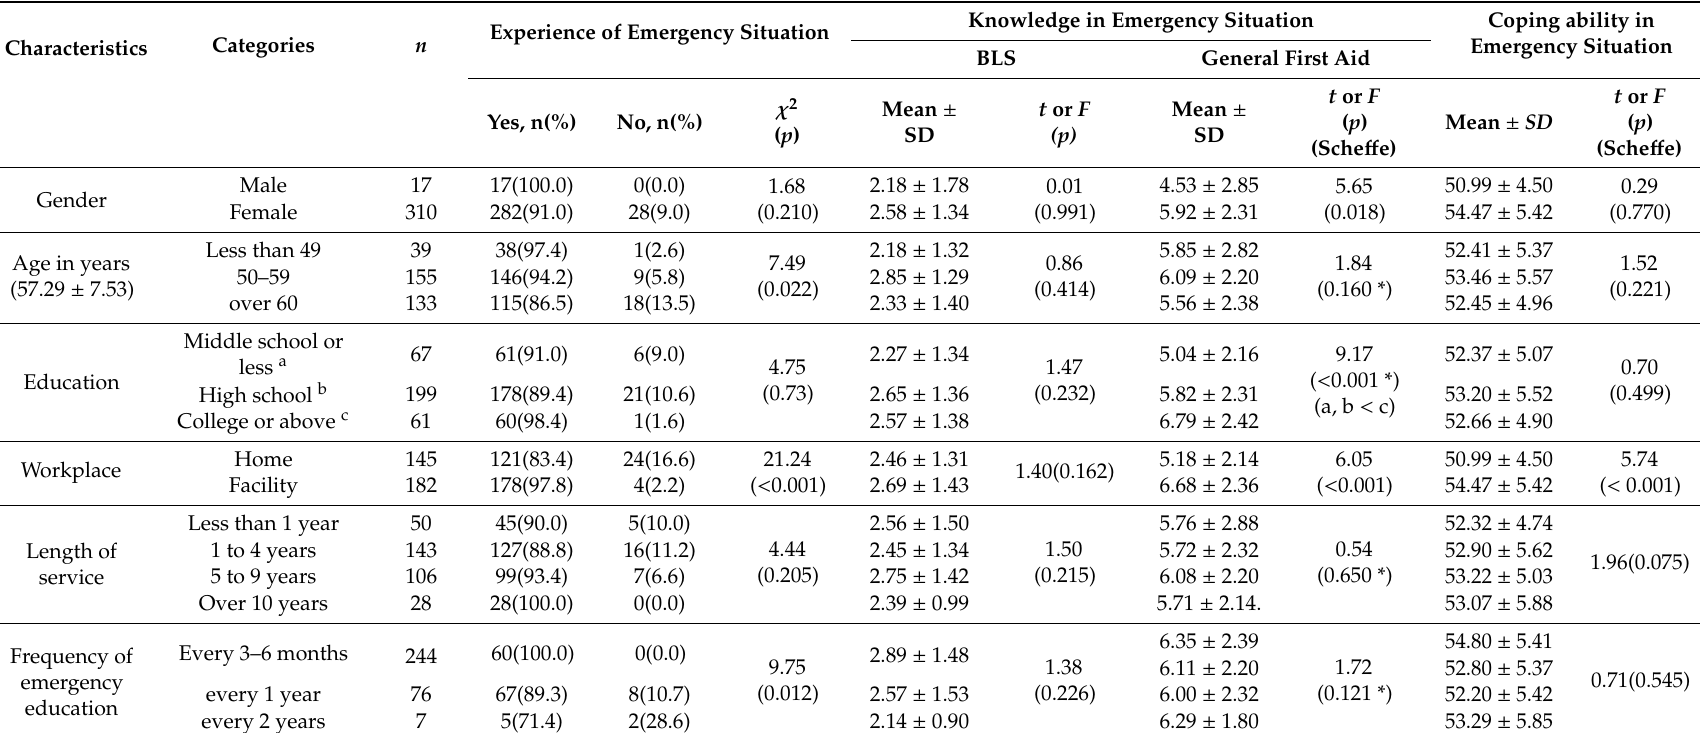
Table 1. Participants’ general characteristics of and di ff erences of variables according to those characteristics ( N =